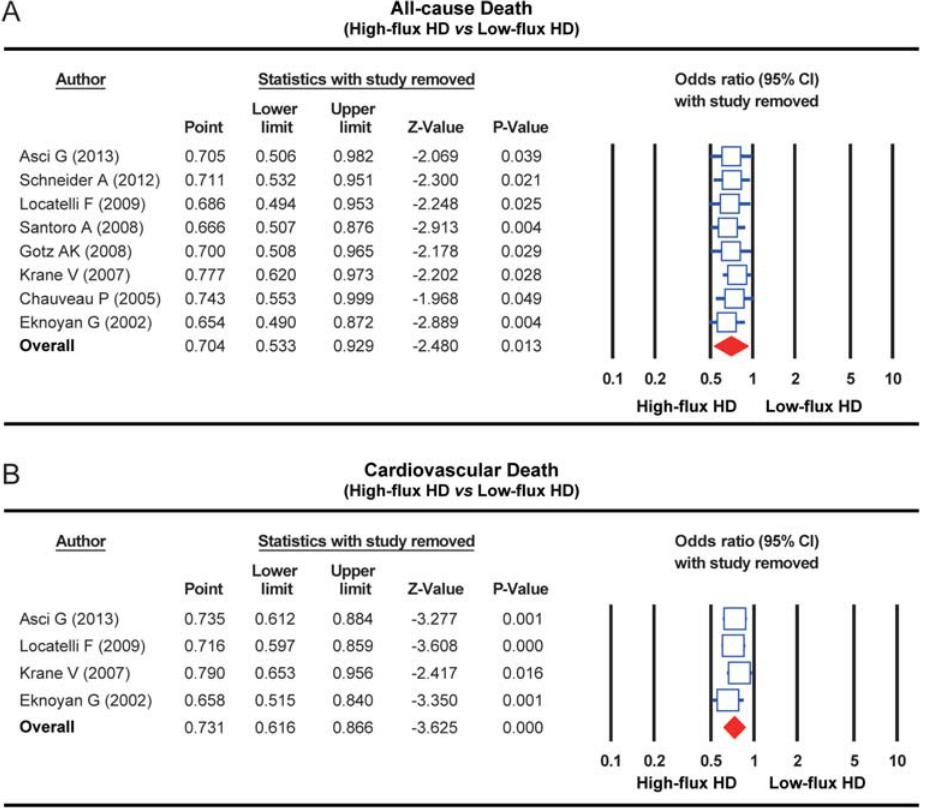
Figure 3. Sensitivity analyses of the in fl uence of high- fl ux hemodialysis and low- fl ux hemodialysis on the all-cause death rate and cardiovascular death rate of patients with chronic renal disease. HD: hemodialysis. See Table 1 for reference